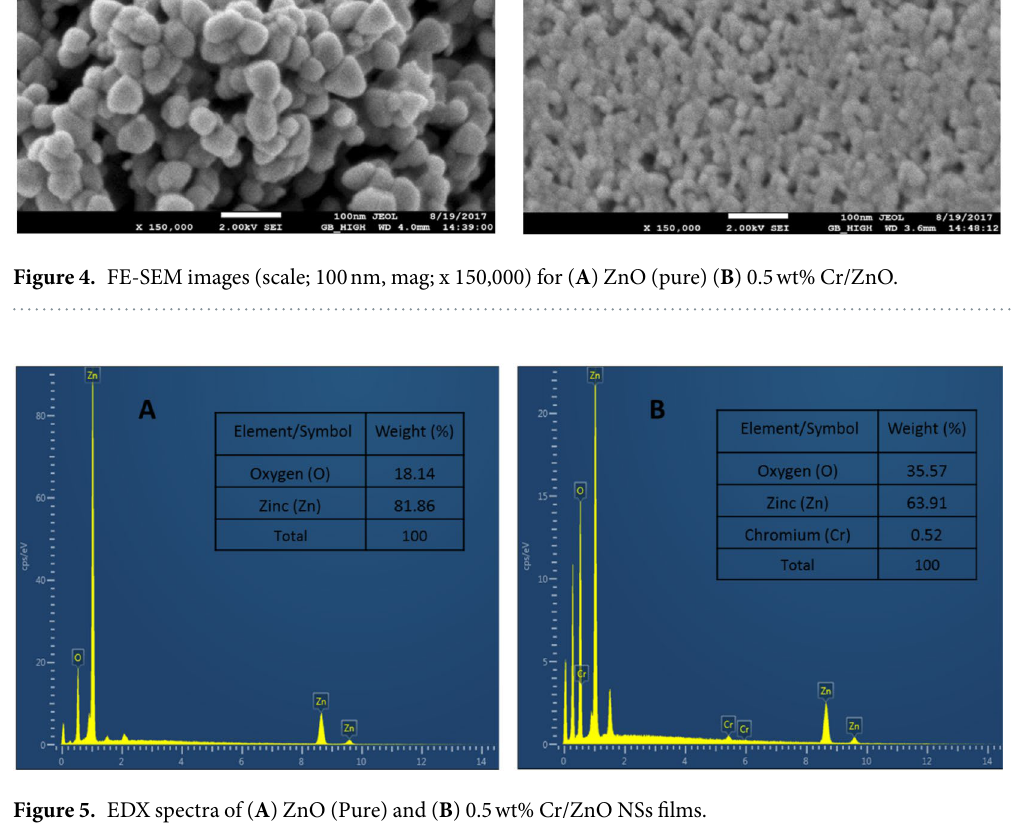
Figure 5. EDX spectra of ( A ) ZnO (Pure) and ( B ) 0.5 wt% Cr/ZnO NSs films.